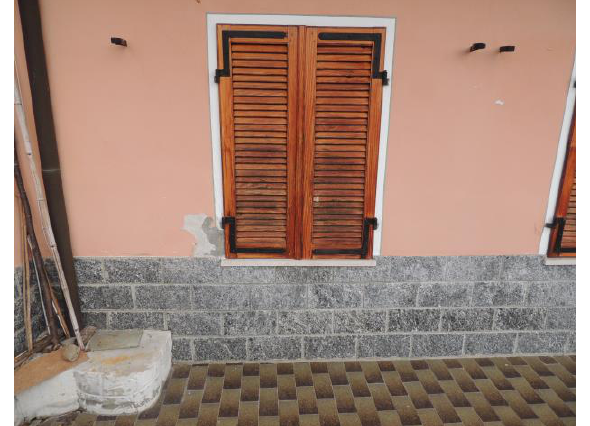
Figure 8. Building E - Baseboard in stone slabs and an external flooring in ceramic tiles, replacement of the windows and application of a new finishing layer (credits Fabio Fratini).